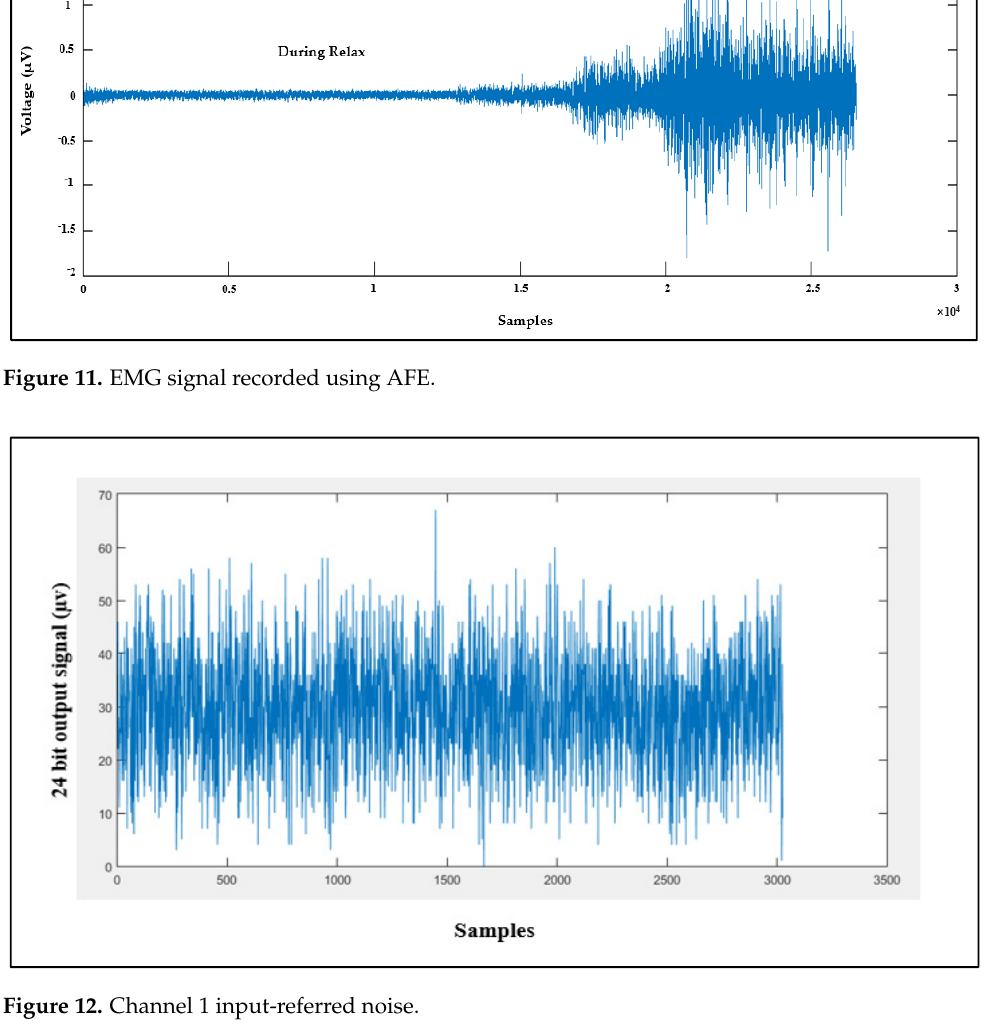
Figure 12. Channel 1 input-referred noise.